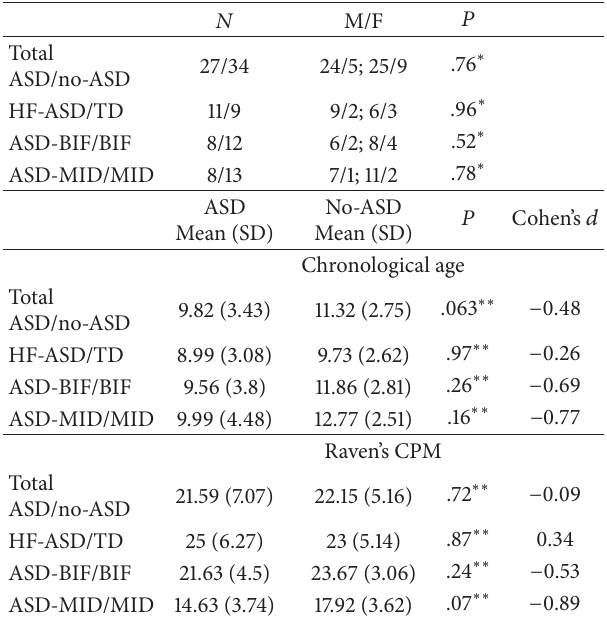
Table 1: Characteristics of experimental (ASD) and control (no- ASD)